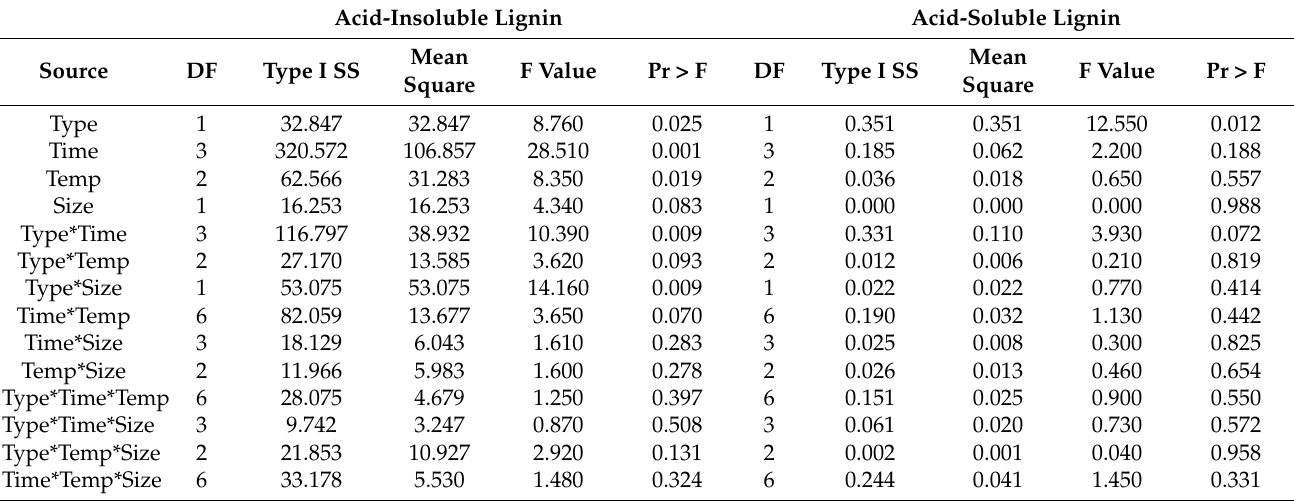
Table 8. ANOVA table of acid-insoluble and acid-soluble lignin for each effect after physical and thermal pretreatment.